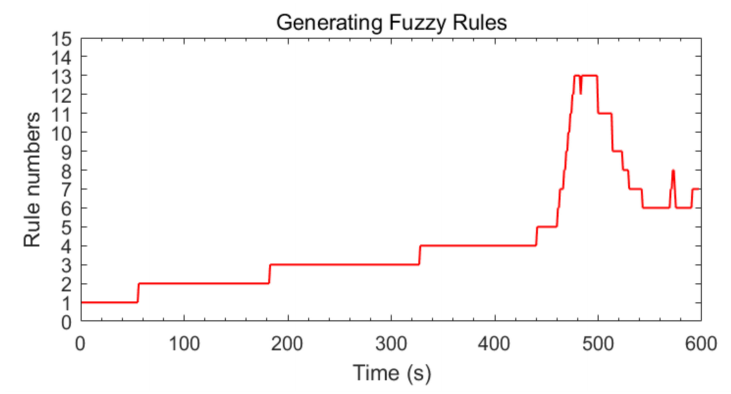
Figure 17. Generating fuzzy rules in